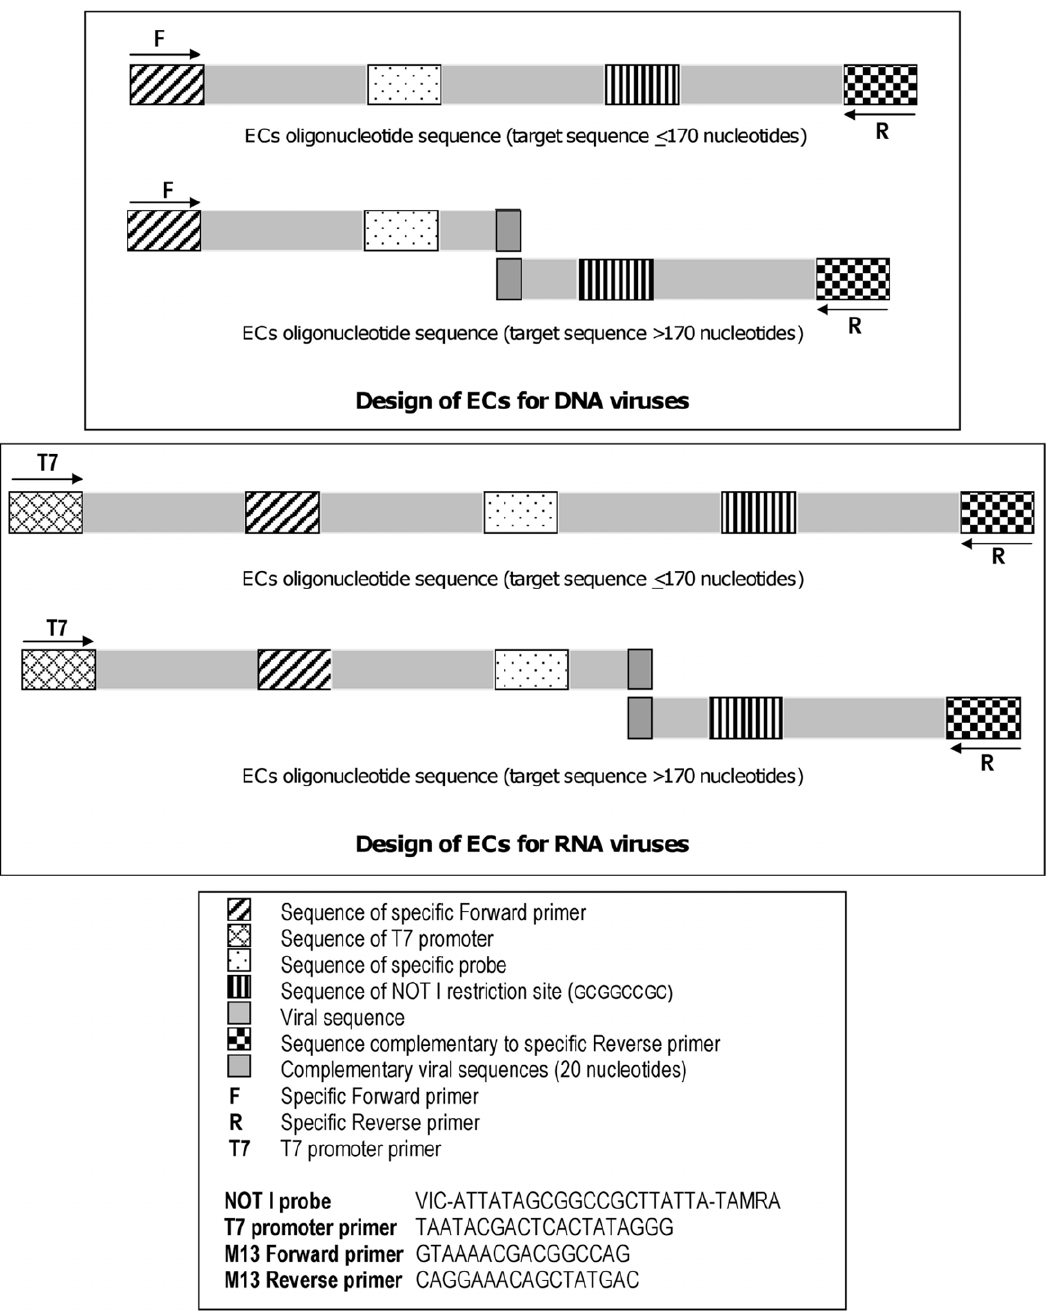
Figure 1. Design of synthetic external controls and sequences of NOT I probe,T7 promoter primer and M13 primers.